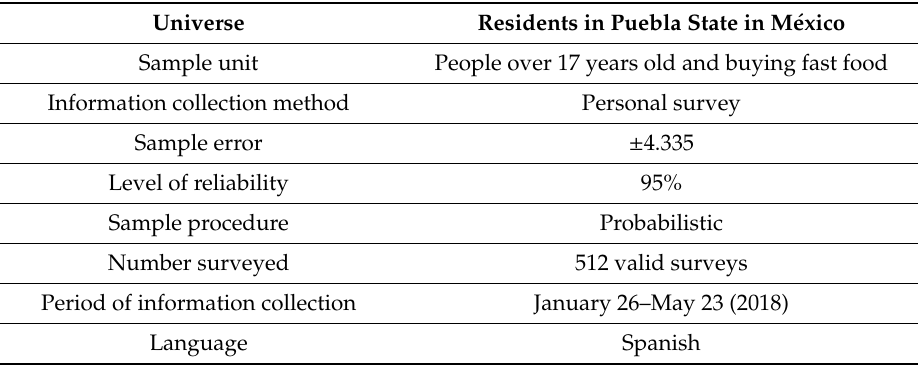
Table 1. Technical